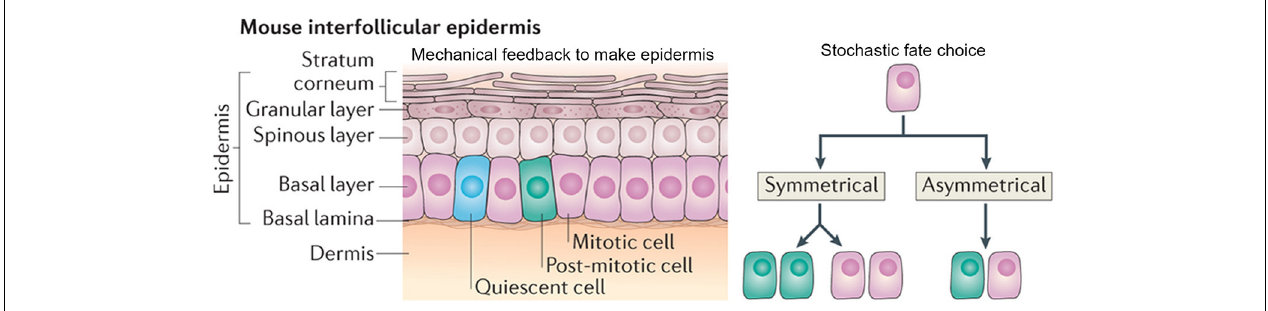
FIGURE 8 | Stochasticity promotes tissue reproducibility in mouse ear epidermis. In the mouse interfollicular epidermis, regular columns of keratinocytes in the stratum corneum differentiate from cells in an underlying basal layer. A new model suggests that the daughters of mitotically dividing basal cells within the basal layer adopt three potential fates in a stochastic but probabilistic manner: (1) two mitotically dividing